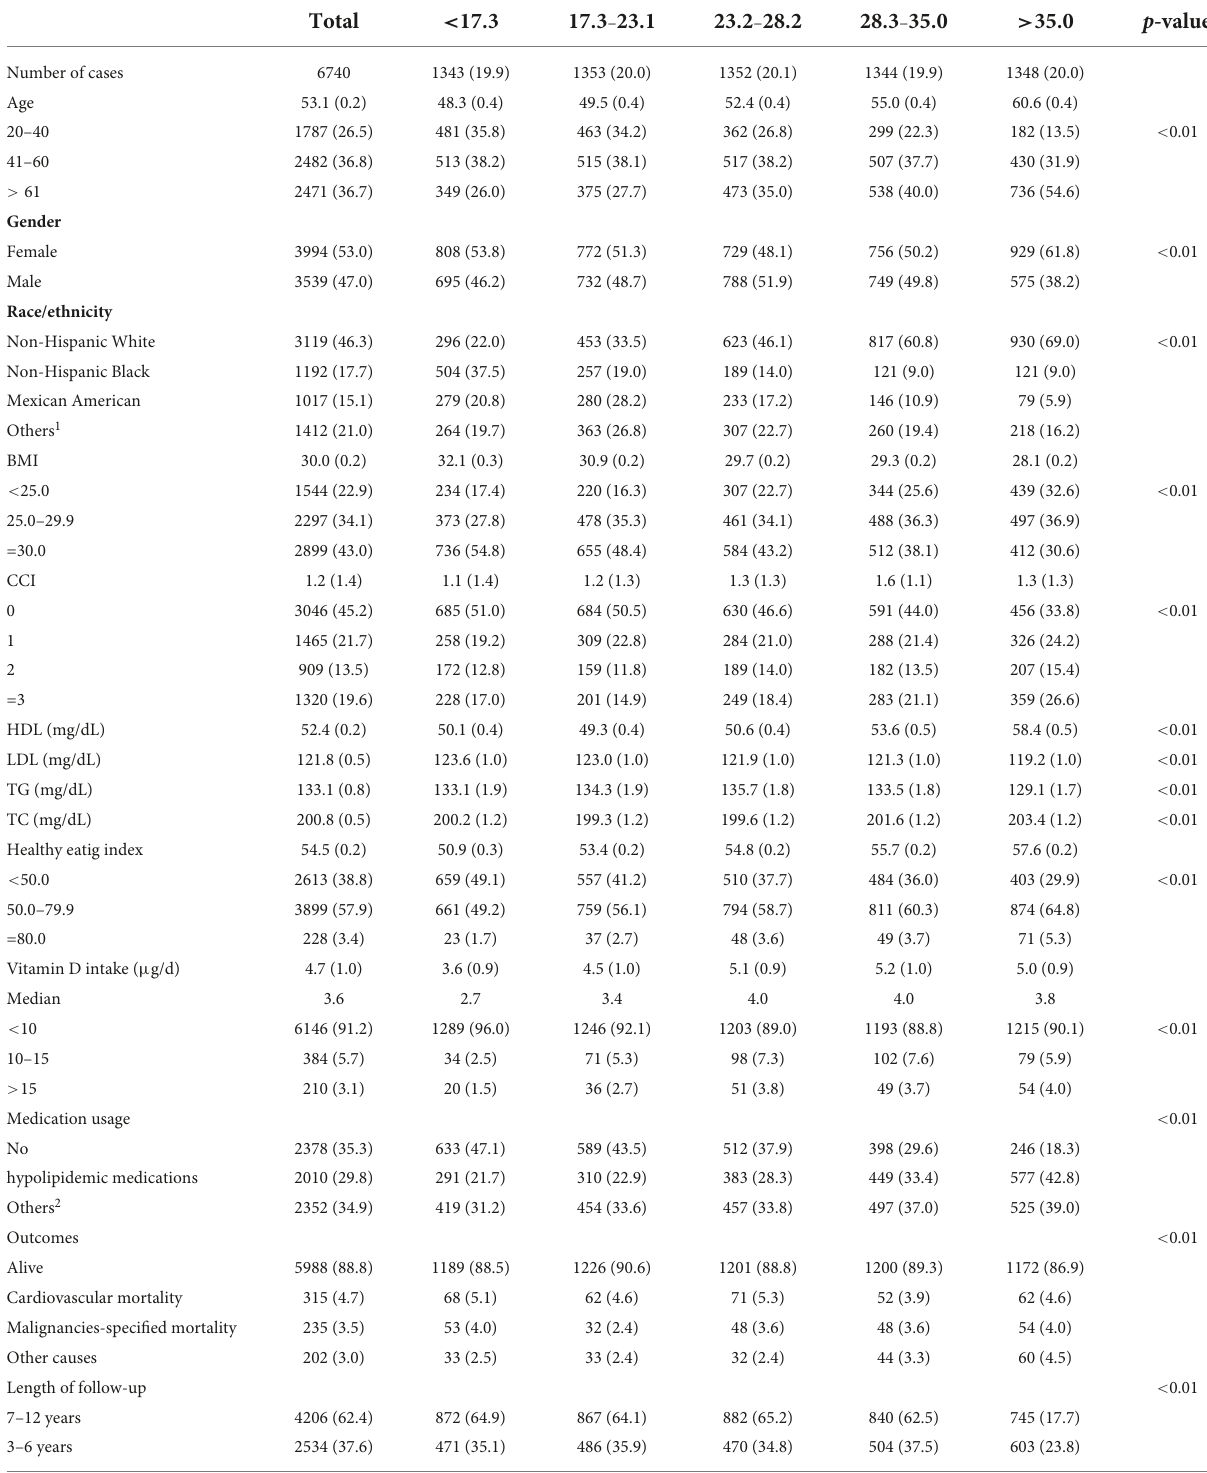
TABLE 1 The baseline of participants with hyperlipidemia according to serum